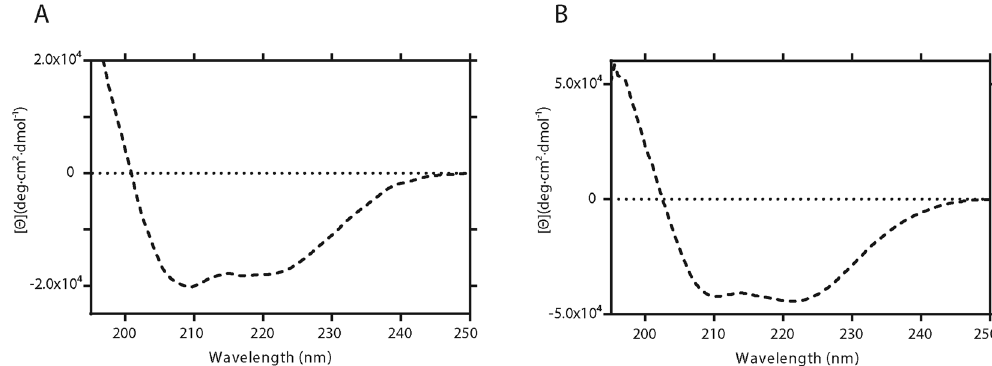
Figure 3. Circular dichroism spectra of malE-en2NTS 1 and E. coli produced en2NTS 1 . Data are represented as mean residue ellipticity for ( A ). CFPS produced malE-en2NTS 1 and ( B ). E. coli produced en2NTS 1 , where both show a profile exhibiting α -helical like structure, as visualised by a pronounced local minima at 208 nm and 222 nm.